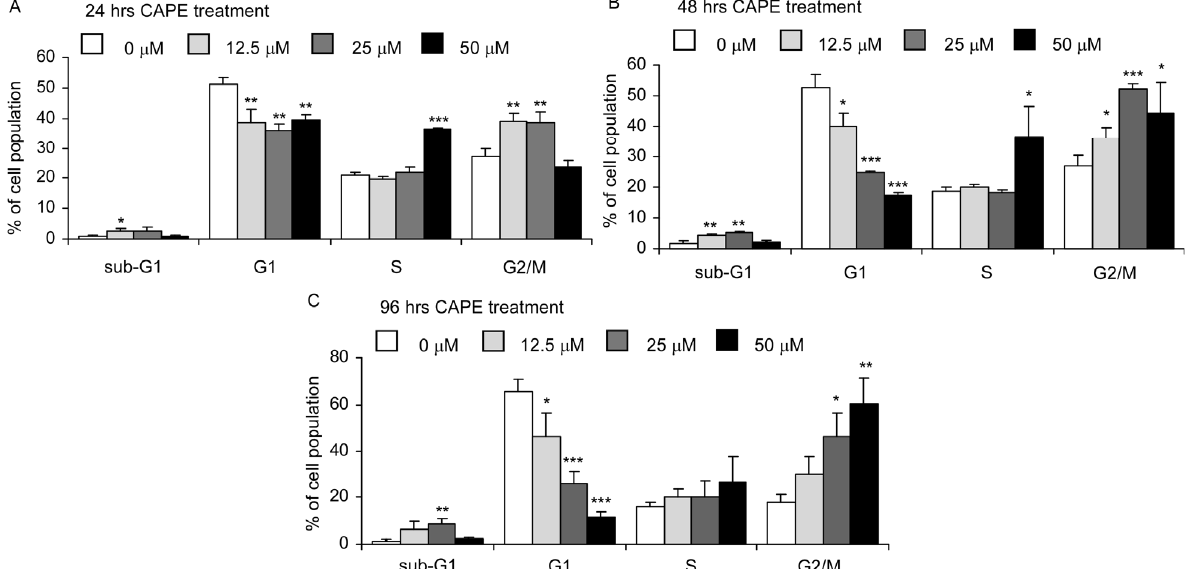
Figure 3. Effects of CAPE on cell cycle distribution of TW2.6 oral cancer cells. TW2.6 oral cancer cells were treated with 0, 12.5, 25, and 50 μ M CAPE for 24 h ( A ), 48 h ( B ), and 96 h ( C ). Cell cycle distribution was determined by flow cytometry. Asterisk ( * , ** , *** ) represents statistically significant difference ( p < 0.05, p < 0.01 and p < 0.001, respectively) between the treated group and the control group.